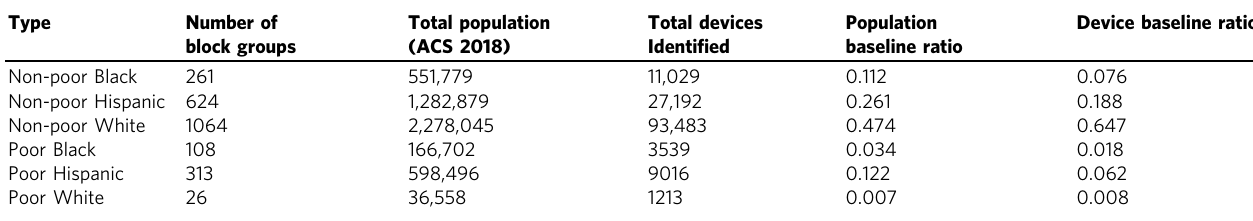
Table 1 Statistics of each type of neighbourhood included in this